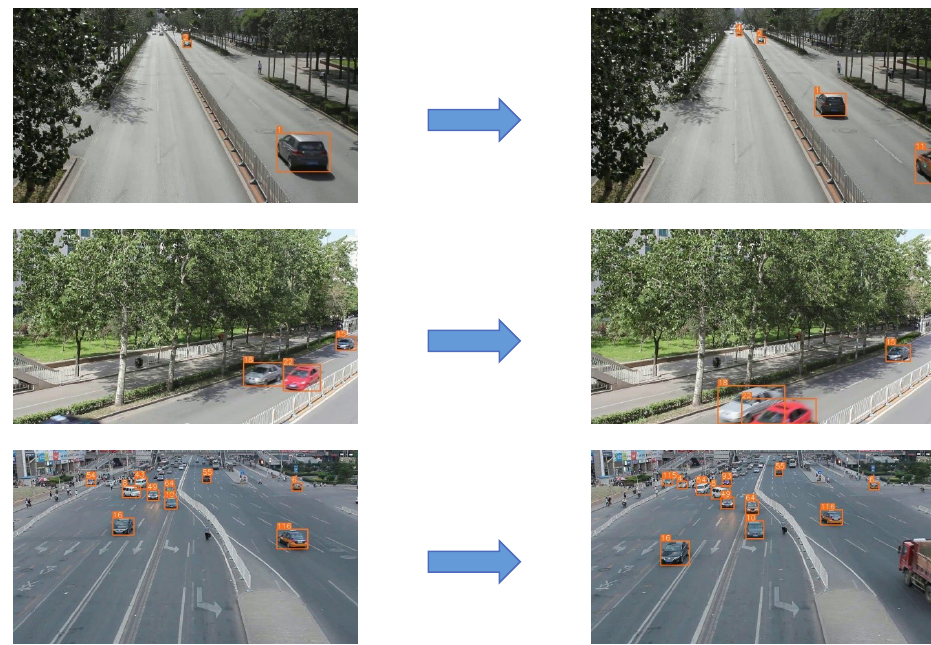
Figure 13. The vehicle target tracking results.